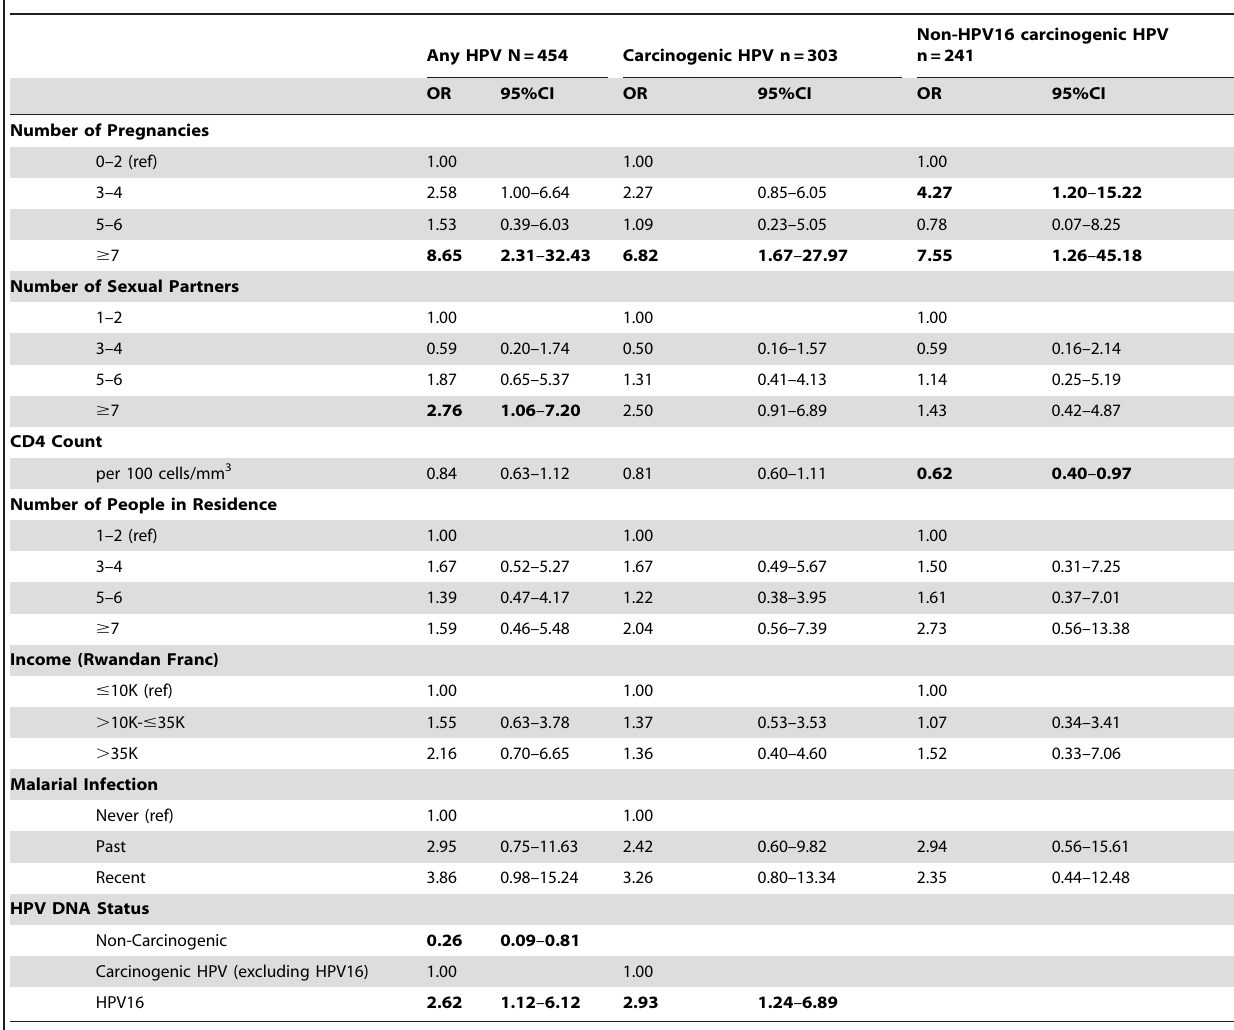
Table 2. Multivariate associations of clinical and demographic characteristics with cervical intraepithelial neoplasia grade 3 or cancer versus less severe than CIN3 among 454 human immunodeficiency virus-infected, human papillomavirus (HPV)-infected women with complete